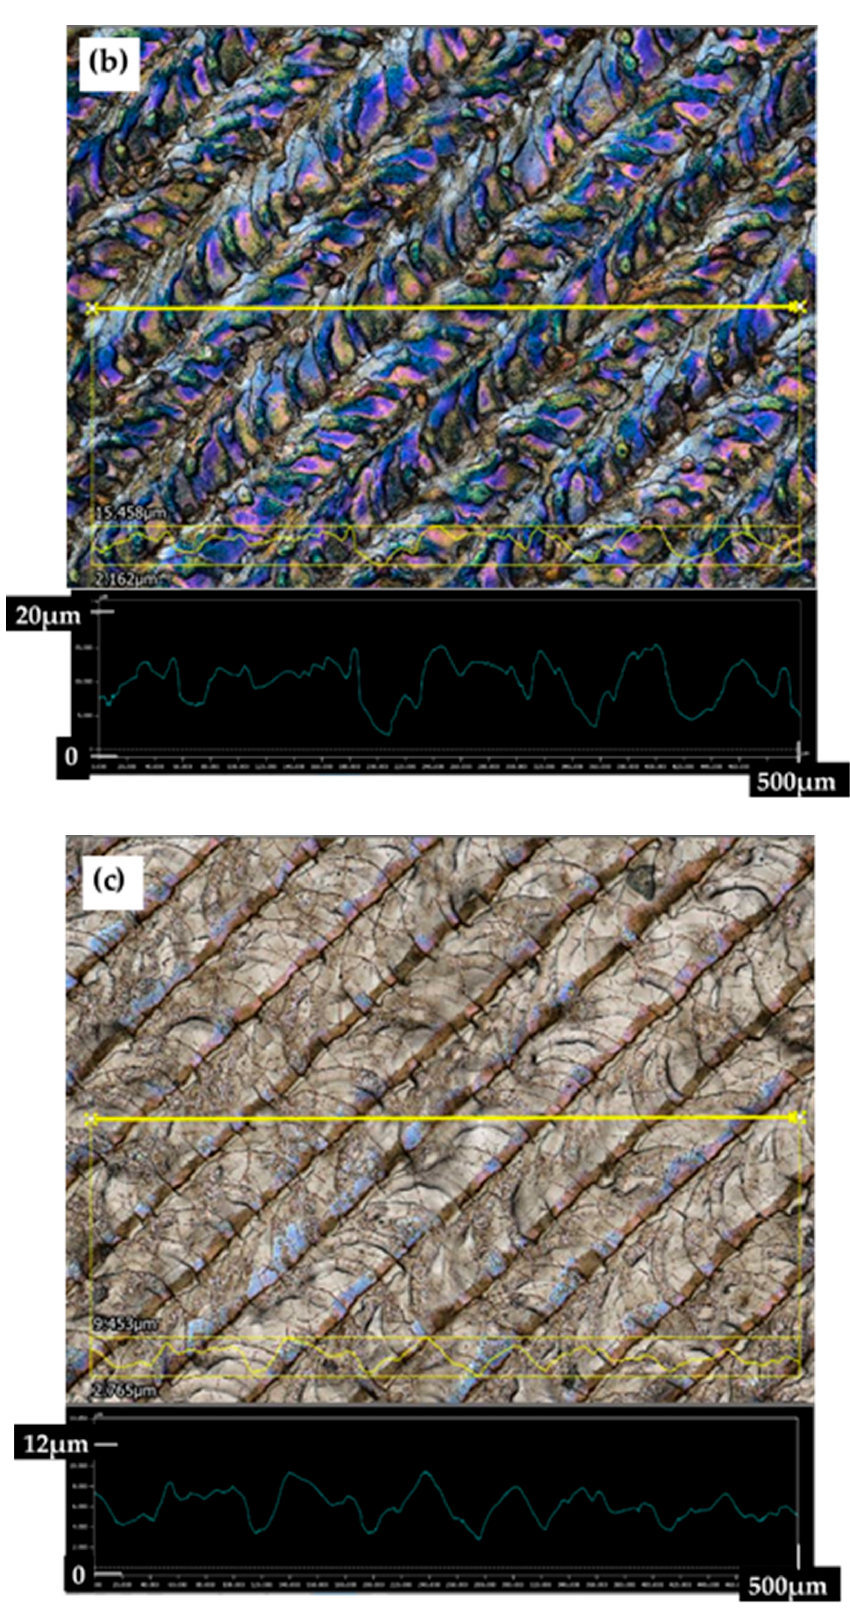
Figure 3. Cross-sections of the laser patterns: ( a ) structure A, ( b ) structure B, ( c ) structure C. According to [35], an increase in surface roughness helps improve cell adhesion, mi- gration and proliferation, which is necessary for biomaterial interaction with the human body. When the focus is on wettability, surface roughness significantly affects surface wet- tability. On the one hand, a higher surface roughness can lead to trapping of air in the roughness asperities and thus cause hydrophobic behavior. On the other hand, it can pro- mote hydrophilic spreading of the droplet on the surface [36].